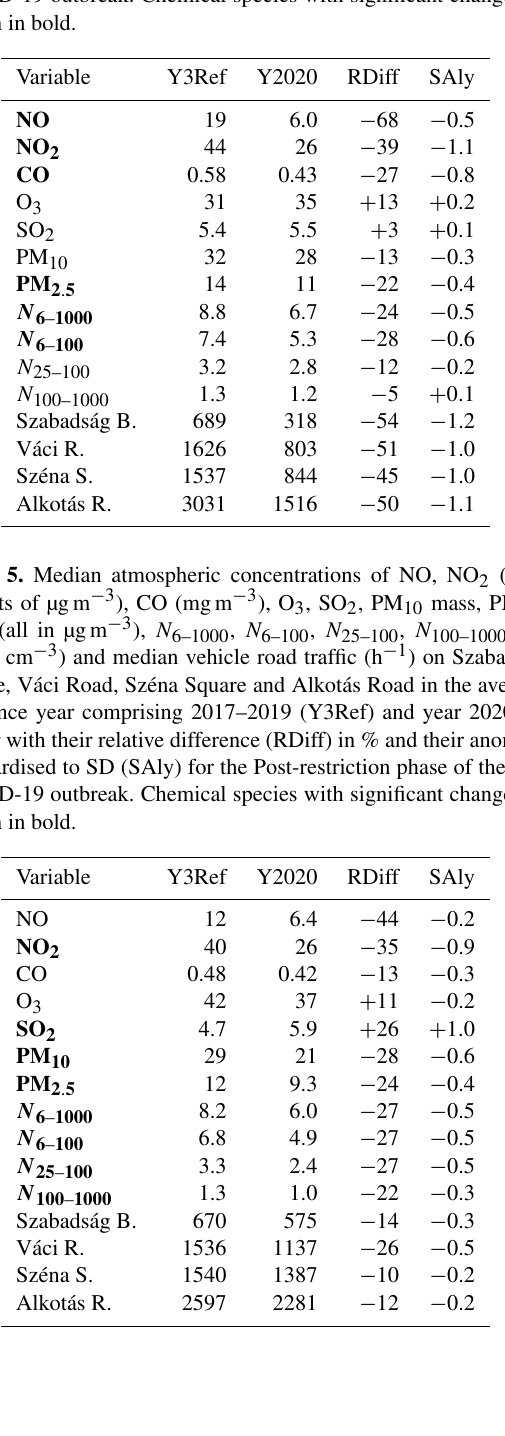
Table 4. Median atmospheric concentrations of NO, NO 2 (both in units of µgm − 3 ), CO (mgm − 3 ), O 3 , SO 2 , PM 10 mass, PM 2 . 5 mass (all in µgm − 3 ), N 6–1000 , N 6–100 , N 25–100 , N 100–1000 (all in 10 3 cm − 3 ) and median vehicle road traffic (h − 1 ) on Szabadság